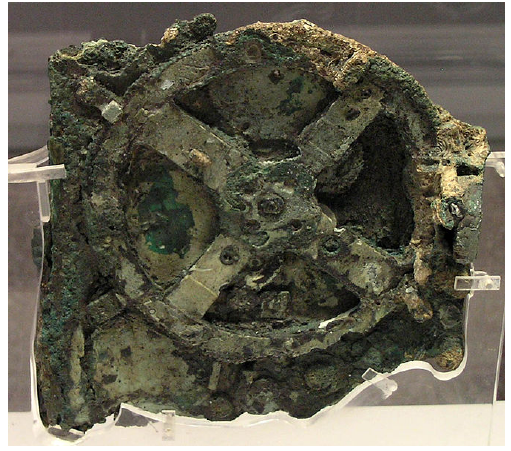
Figure 1.The Antikythera mechanism, (Courtesy of the National Archaeological Museum of